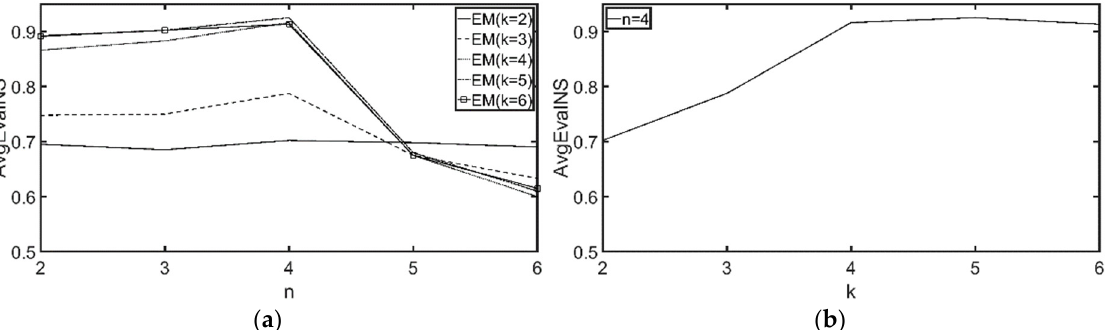
Figure 15. AvgEvalNS with ( α k = 4, α n = 4, CAL) resulting from different k , n. ( a ) resulting from different n . ( b ) resulting from different k .